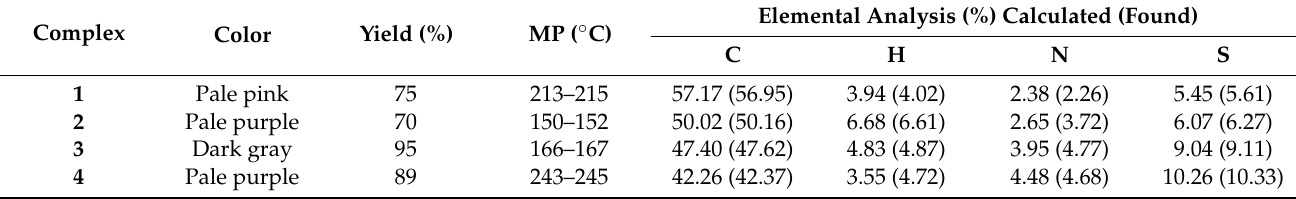
Table 2. IR spectral data of tin-naphthalene sulfonic acid complexes 1 – 4 .